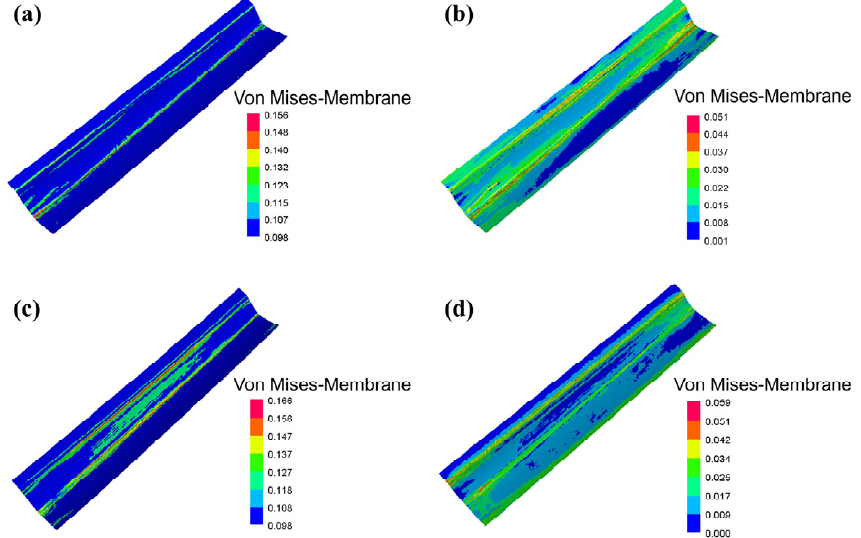
Figure 9. von Mises stress distribution before and after springback: ( a , b ) Hot stamping.; ( c , d ) Draw- ing.